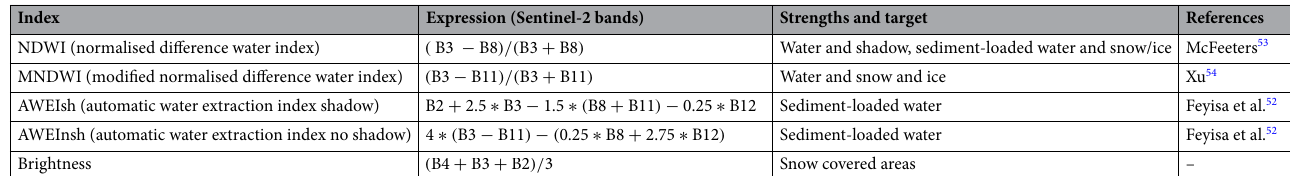
Table 1. Description of each of the spectral indices used in this study and their detection